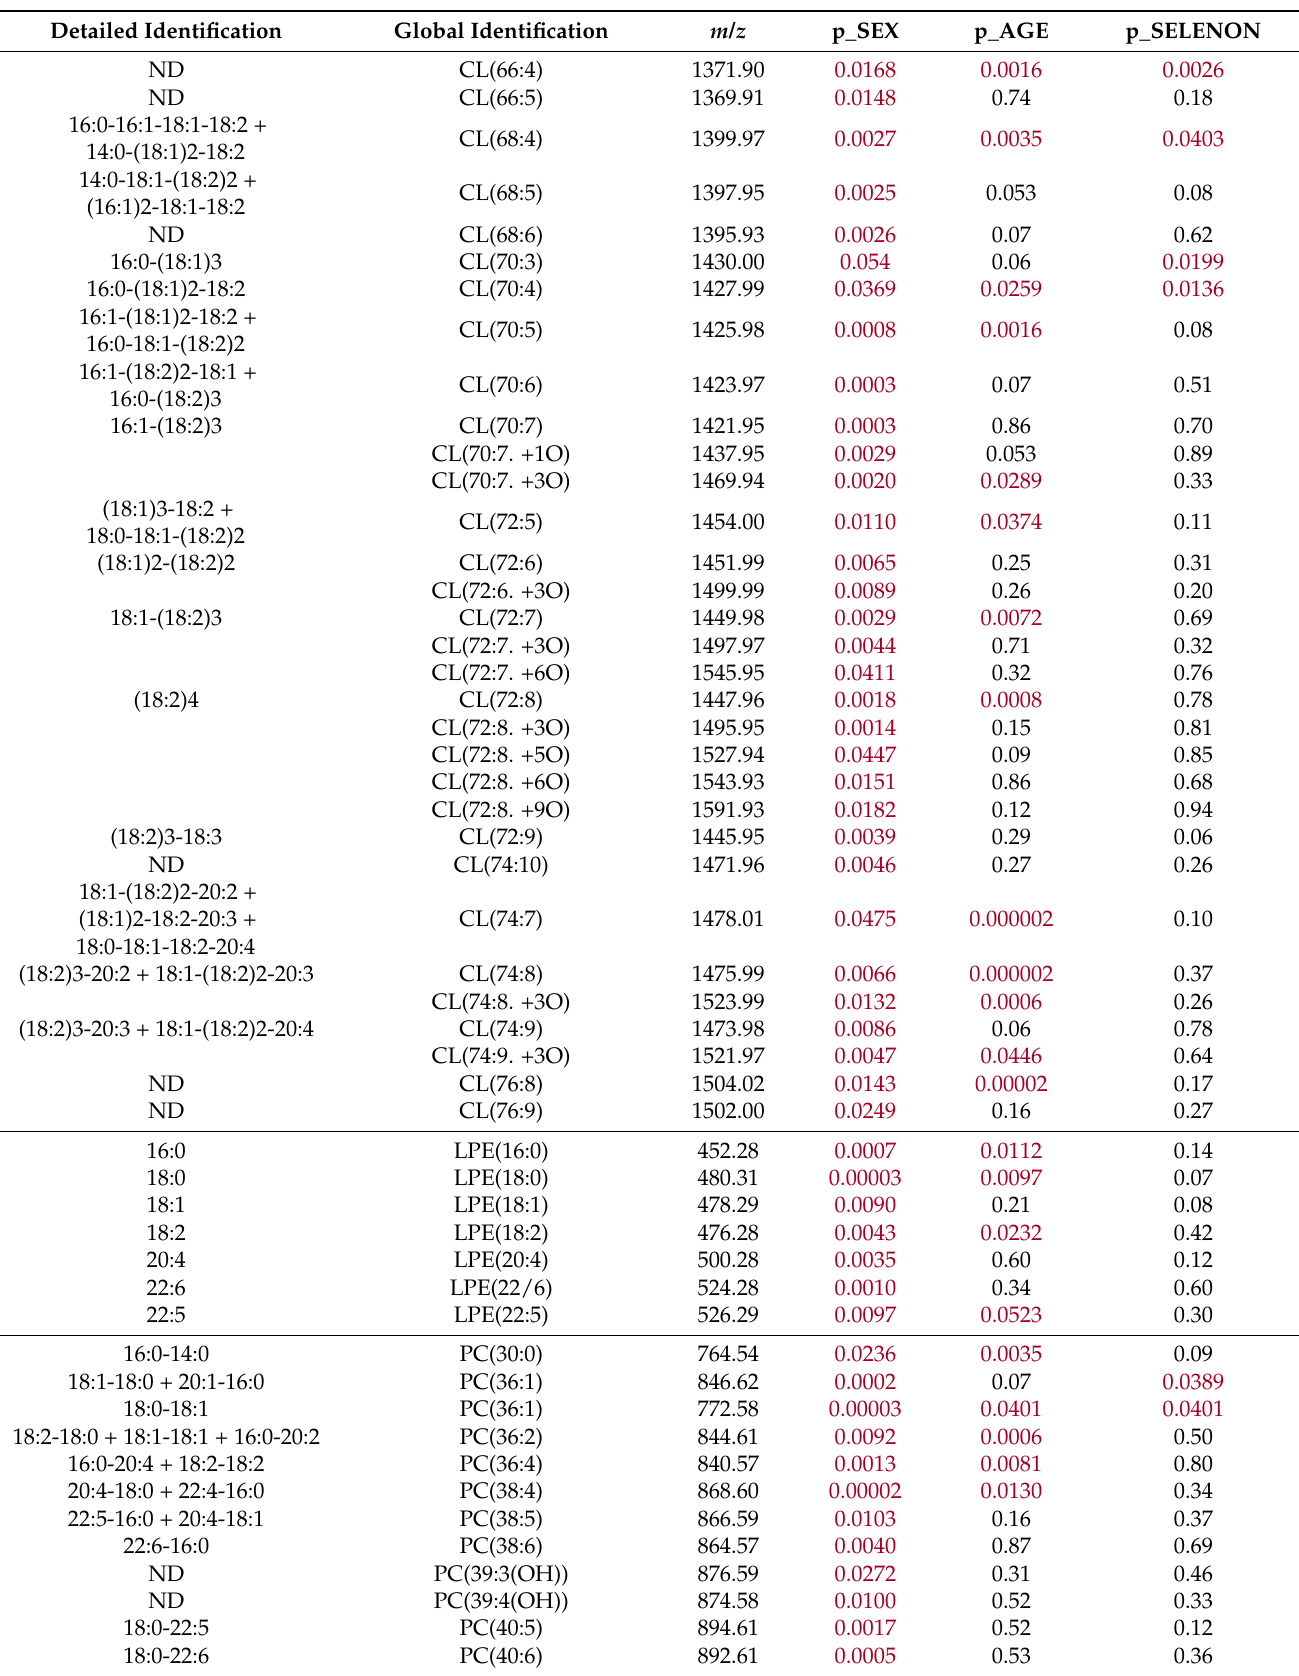
Table 2. Sex-significant PLs in